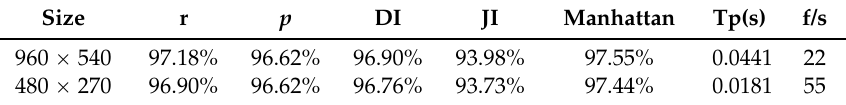
Table 3. Average metrics obtained over 30 images of initiating fire processes.